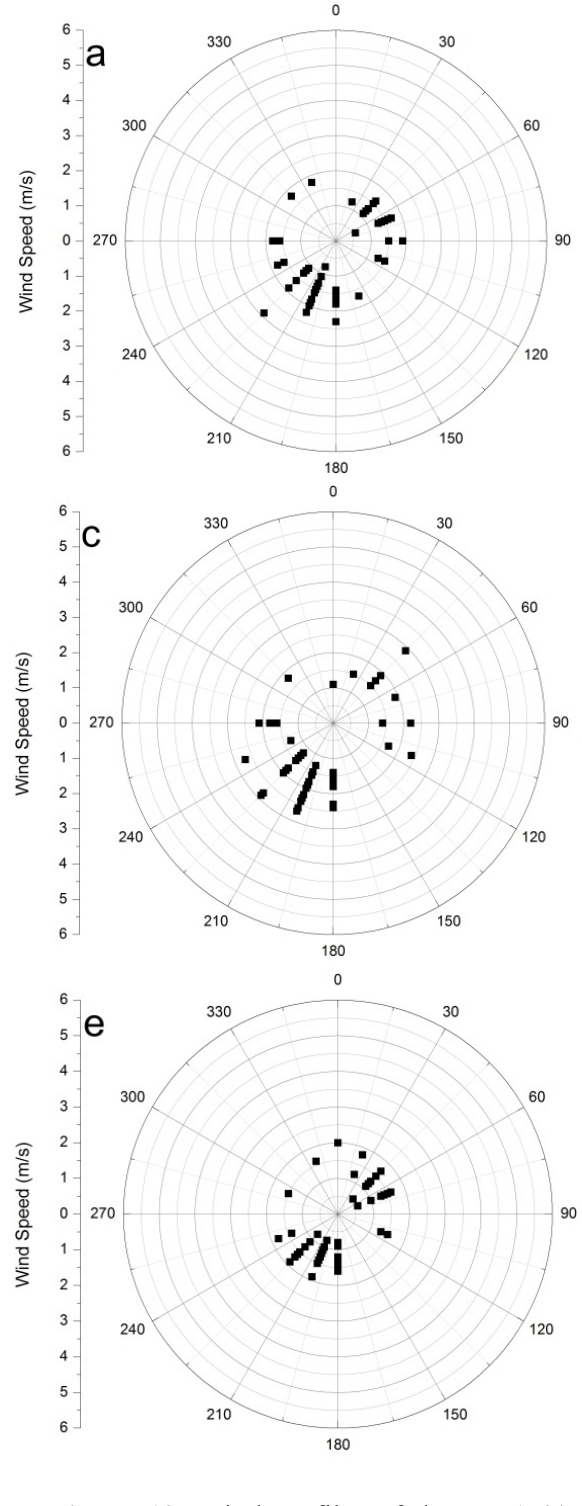
Figure 12. Wind profiles of the top 15% measurements of each pollutant for Station 1: Dongsi in urban Beijing (( a ) PM 2.5 , ( b ) PM 10 , ( c ) O 3 , ( d ) SO 2 , ( e ) NO 2 , and ( f )